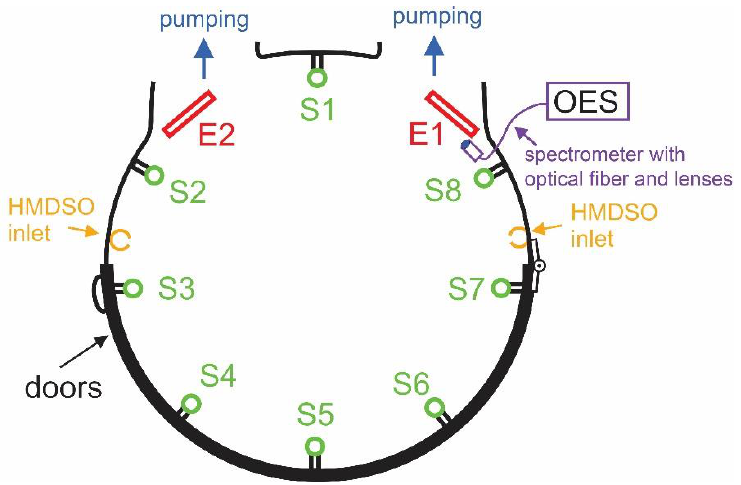
Figure 1. Cross-section of the cylindrical PECVD reactor with the position of the pump ducts, powered electrodes (E1, E2), HMDSO inlet, sensors for deposition rate measurements (S1−S8), OES lens, optical fiber and OES spectrometer.